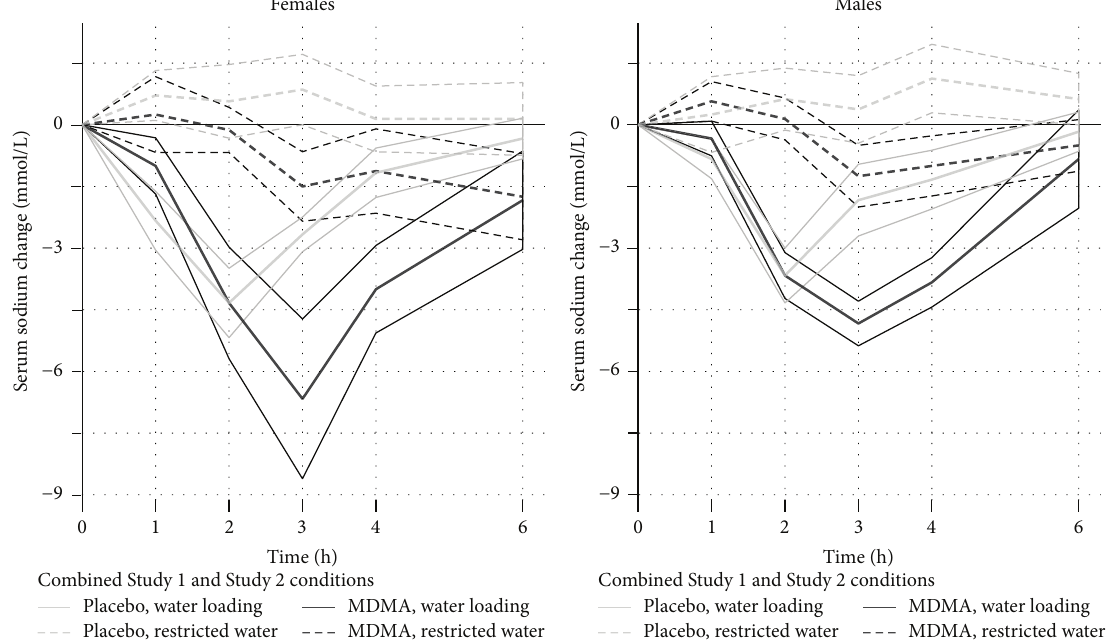
Figure 6: MDMA impairs serum sodium homeostasis after water loading. Plot shows effects of MDMA and water loading on serum sodium using data pooled across Studies 1 and 2. Outlines indicate